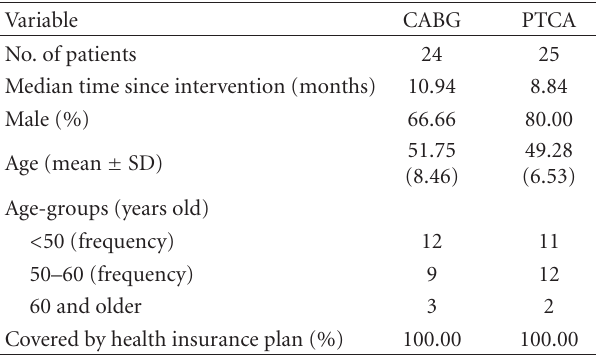
Table 1: Patients’ characteristics at the first round interview (first year